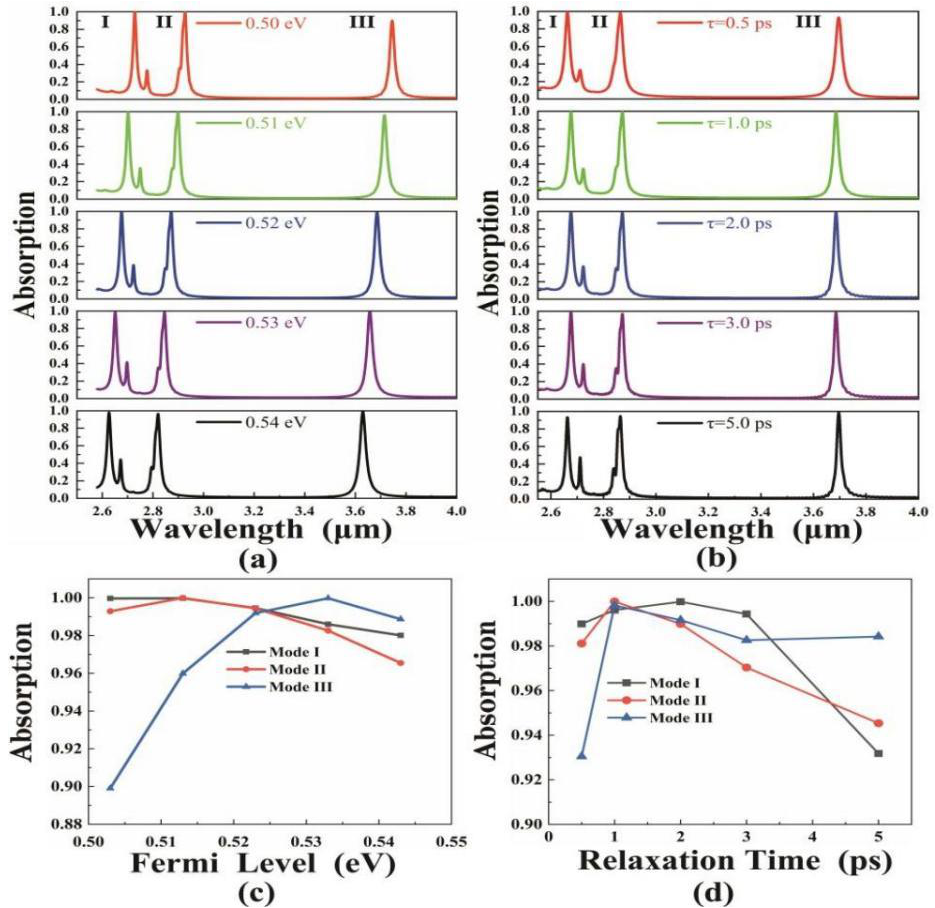
Figure 7. ( a ) Variation curves of the resonance wavelength as the Fermi level increases with an interval of 0.01 eV. ( b ) Variation curves of the resonance wavelength as relaxation time increases with an interval of 0.5 ps. ( c ) Fluctuation situation of the absorption efficiency of three modes with the independent variable being the Fermi level. ( d ) Fluctuation situation of the absorption efficiency of three modes with the independent variable being the relaxation time.